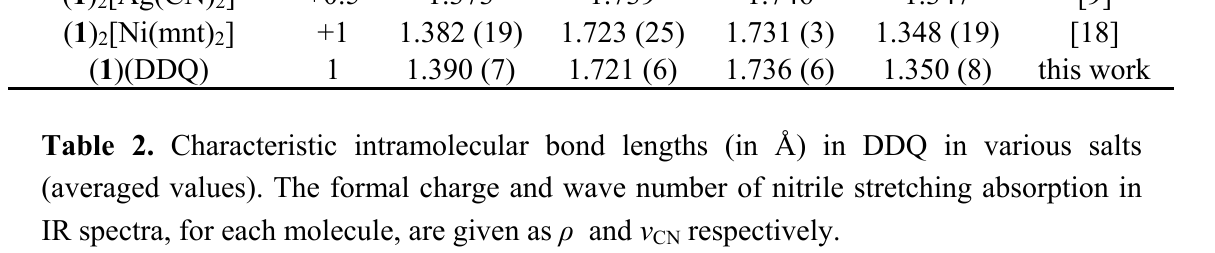
respectively. CN